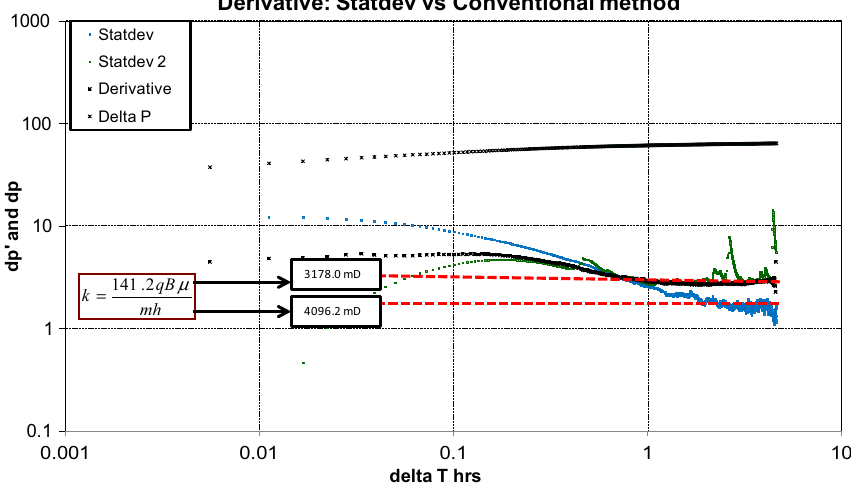
Fig. 10 Comparison of conventional and statistical derivatives versus